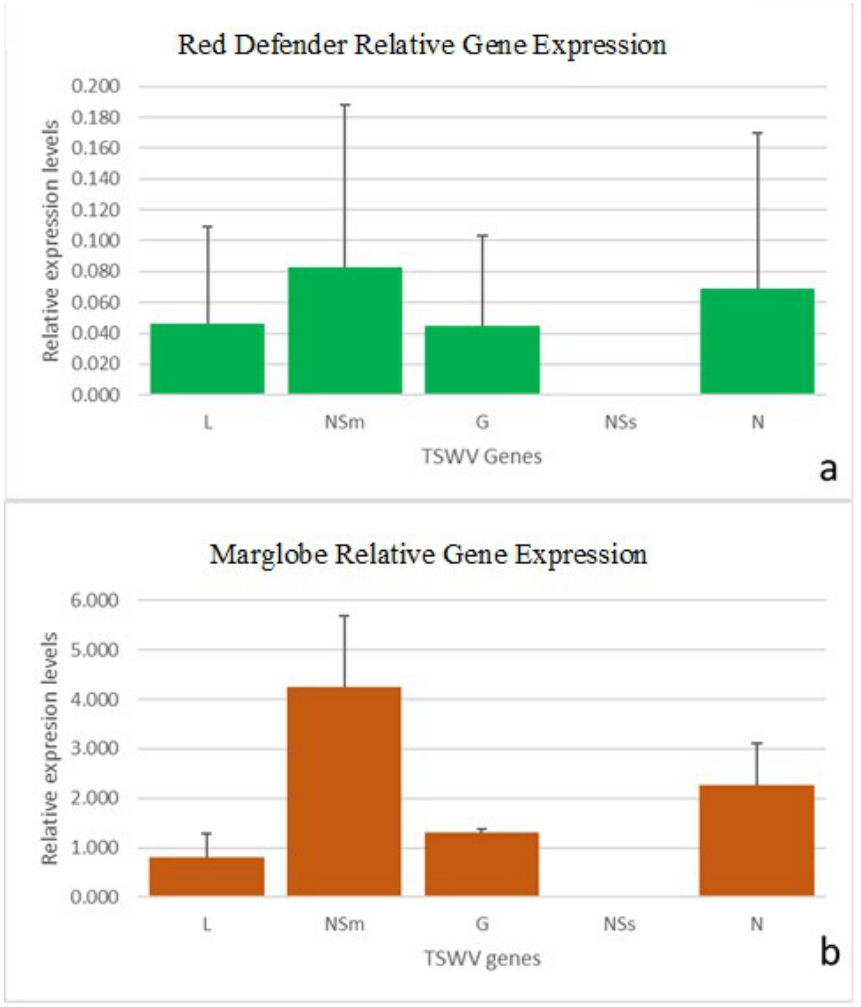
Figure 7. Relative expression of tomato spotted wilt virus (TSWV) genes in two tomato varieties, ( a ) The resistant variety Red Defender inoculated with TSWV. ( b ) The susceptible variety Marglobe inoculated with TSWV. Elongation factor 1-alpha (EF1a) and Glyceraldehyde 3-phosphate dehydrogenase GAPDH were used as the host genes for normalization. Error bar indicates the standard deviation. The bar correspondes to a delta-Ct nomalized Cts of the three biological replicates and three technical replicates per each one. L: Polymerase; NSm: Movement protein; G: Glycoprotein precursor; N: Nucleoprotein; NSs: Silencing suppressor.